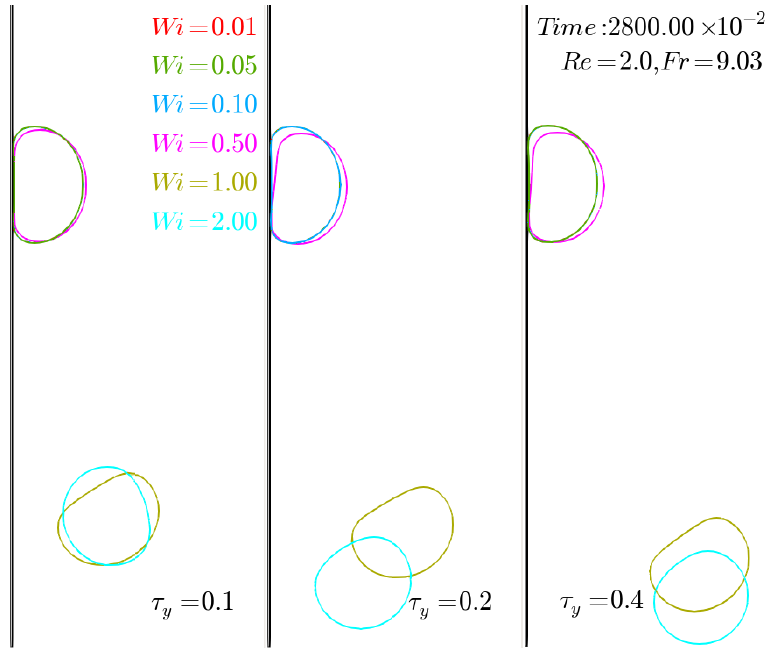
Figure 14. Collision of drops on a vertical wall for fixed values of the Reynolds, Re = 8, and plastic numbers, τ y = 0.4 and the following values of the Weissenberg number, Wi = { 0.01;0.1;0.5;1 } . ( left column ) Fr = 4.52; ( right column ) Fr = 1.13. Dimensionless time, t =